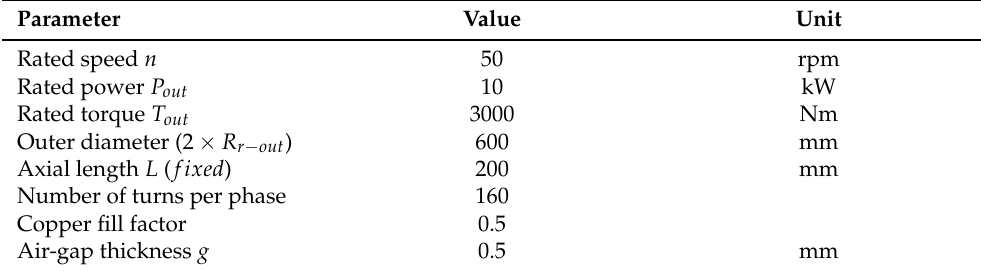
Table 1. Problem